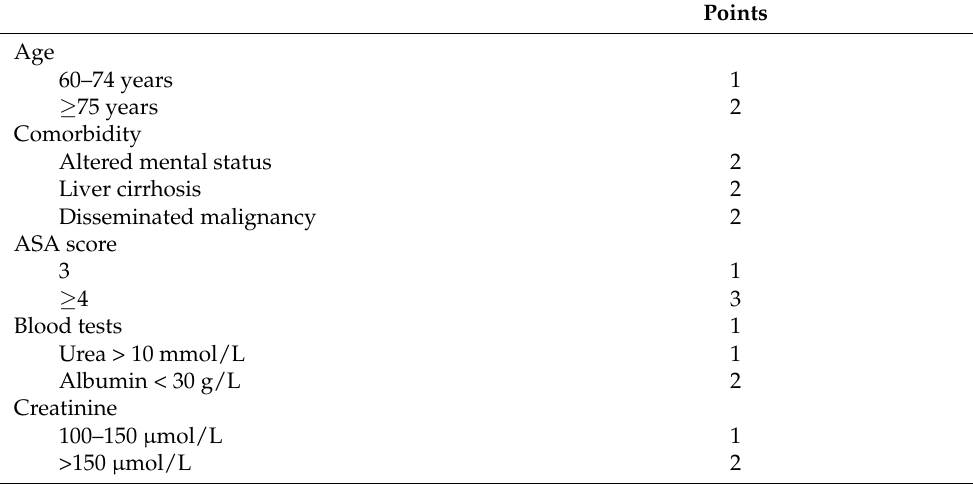
Table 10. INBS (ABC) score